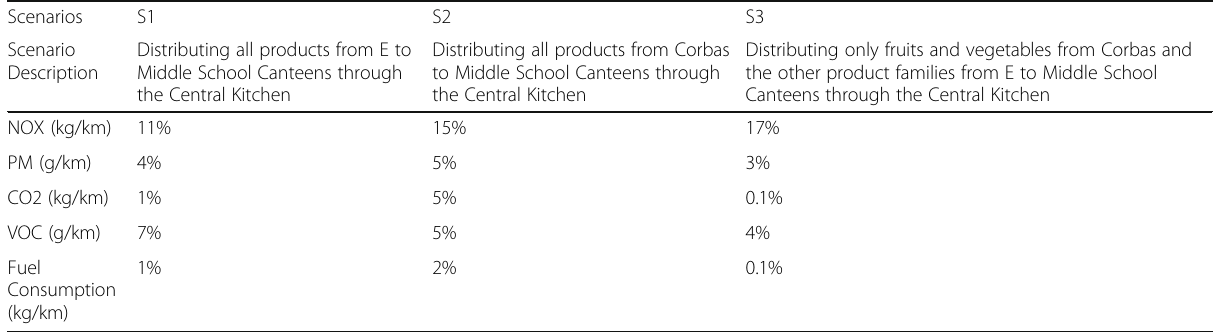
Table 13 Comparison between environmental evaluation results from VRP-SS and VRP-ANNONA Scenarios S1 S3 Scenario